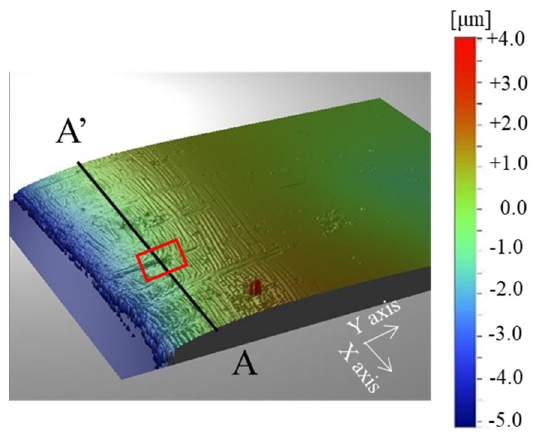
Figure 6. Three-dimensional shape measurement data of electrical amorphous steel sheet induced by piercing in a single shot with the use of normally ground WC (Co) punch that showed in Figure 5.